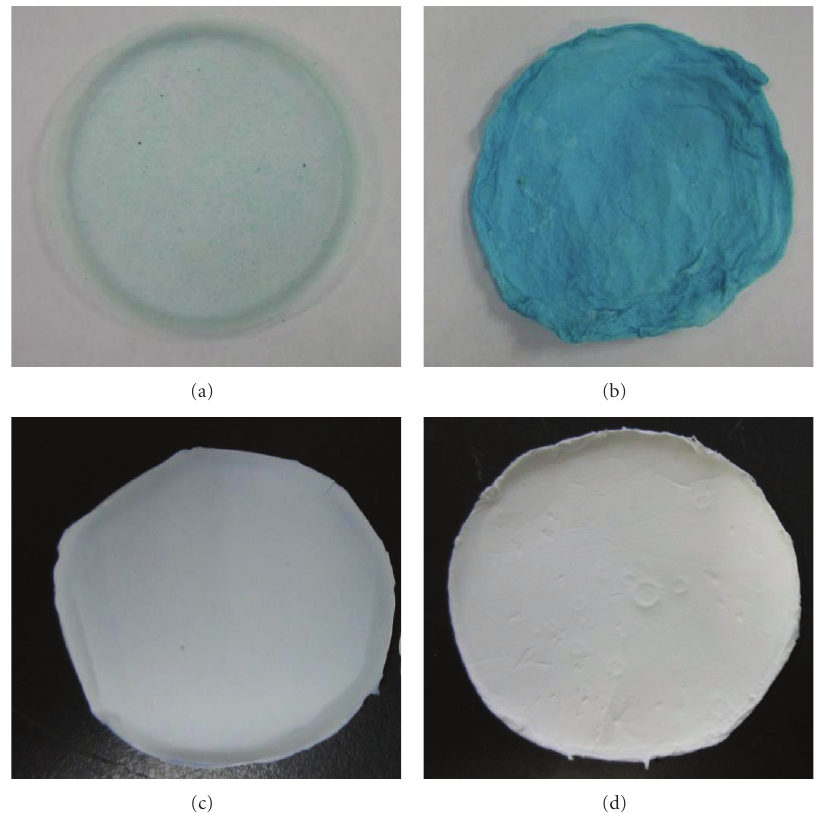
Figure 5: Digital images of (a) cast P(3HB), (b) electrospun P(3HB), (c) cast P(3HB)-50wt% TiO 2 , and (d) electrospun P(3HB)-50wt% TiO 2 films, respectively, at the end of photocatalytic decolorization of MG under sunlight.